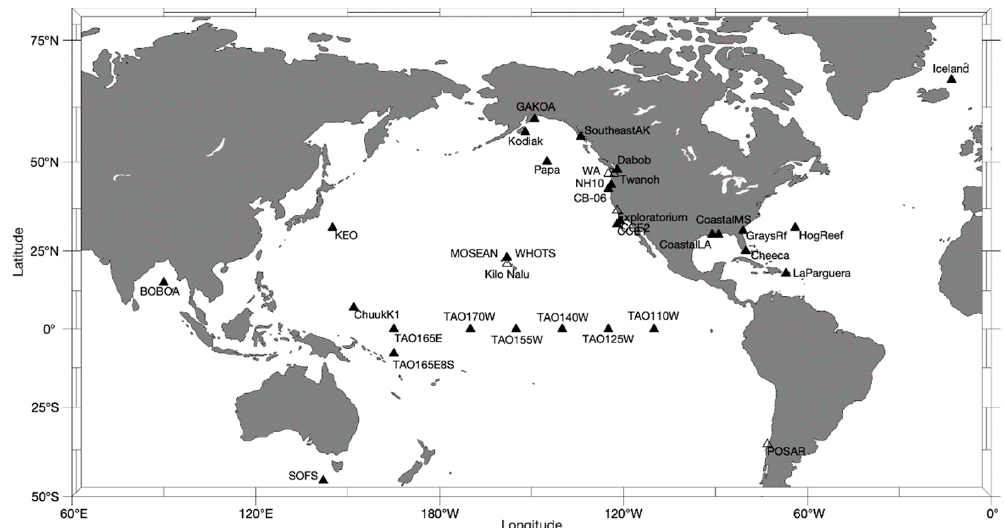
Figure 2. Map of global buoy stations. ▲ indicates the selected stations for this study.